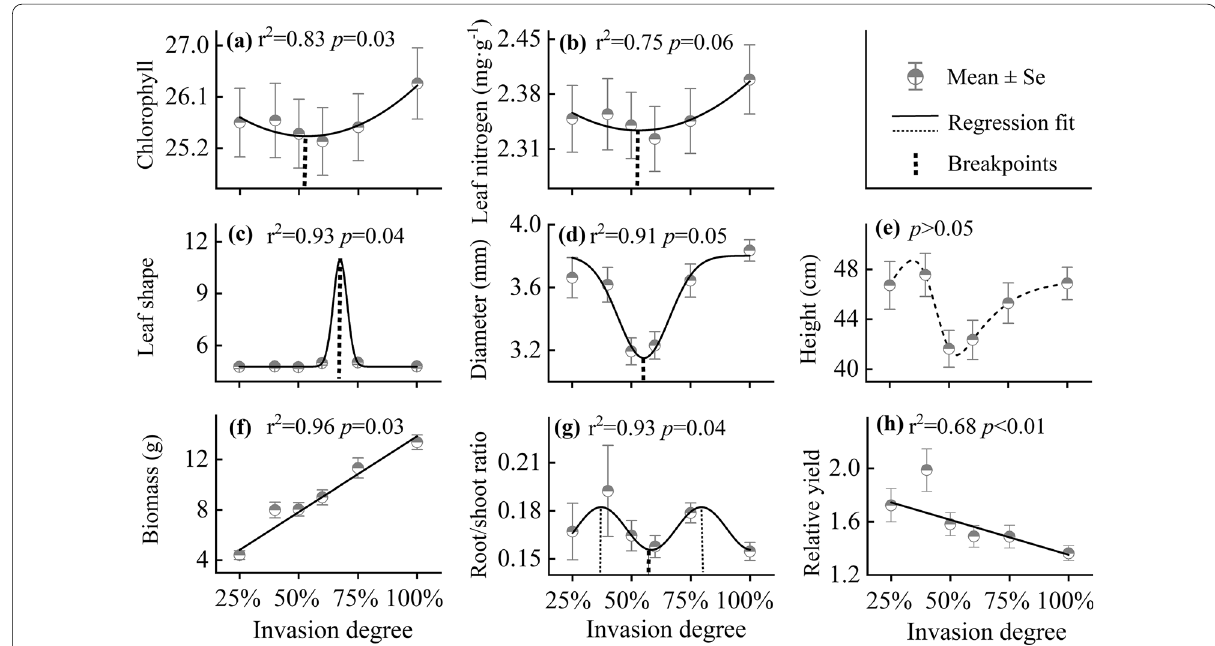
Fig. 2 Growth and changed competitiveness of Solidago canadensis at differing degrees of invasion. Ecological traits show different patterns of response to the gradient of invasion (25–100% invasion levels), which displayed linear or non-linear relationships. Solid lines represent significant linear or non-linear fits, dashed lines represent non-significant linear or non-linear fits, and vertical dotted lines indicate the breakpoints identified via piecewise regressions. Error bars represent the SEs of the means (N 70) =